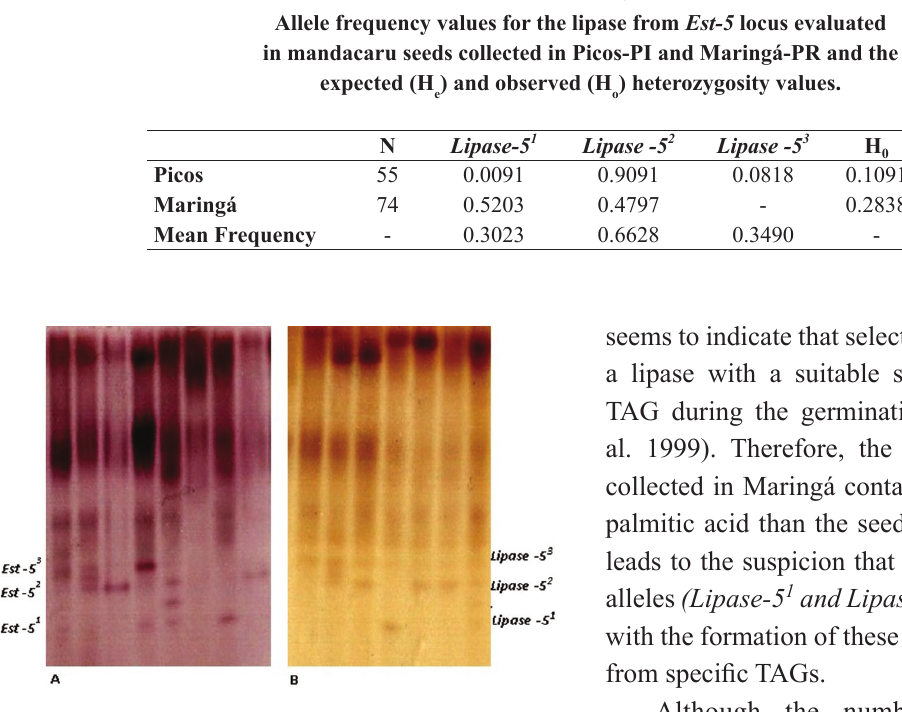
Figure 2 - Polymorphism evaluated at locus Est-5 ( Lipase-5 ) for mandacaru seeds collected in Picos; the alleles Est-5 1 , Est-5 2 and Est-5 3 ( A ) were observed, which correspond to Lipase-5 1 , Lipase-5 2 and Lipase-5 3 ( B ),